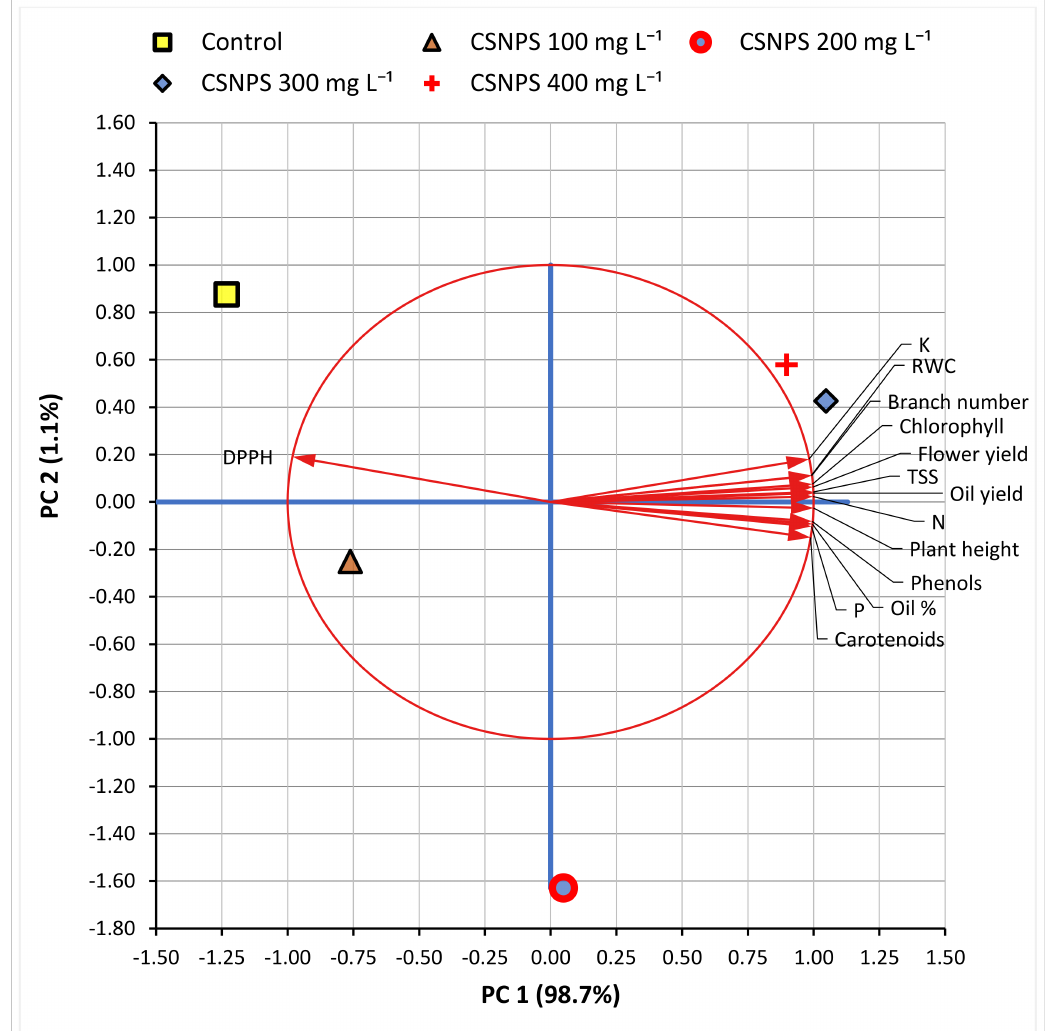
Figure 5. Biplot of the principal component analysis (PCA) for chamomile plant parameters in response to CSNPs treatments. The first two principal components (PC1 and PC2) explained 99.8% of the total variation. The circle represents perfect (maximum) correlation ( ± 1). The vectors (arrows) represent the variables, and the colored shapes represent sampling points under various treatments of CSNPs and the